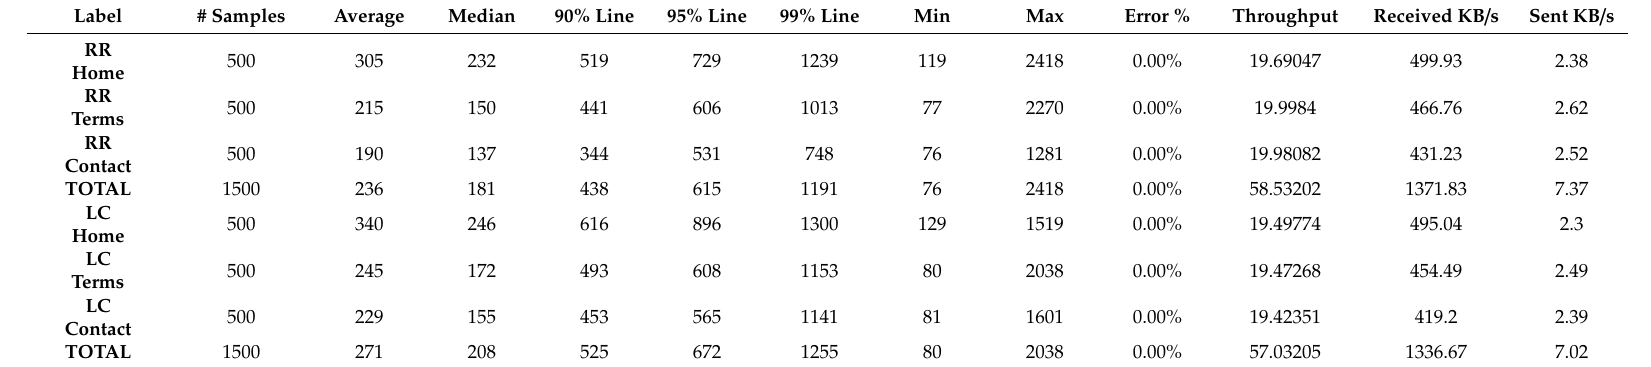
Table 4. Statistics table of the RR algorithm and LC algorithm for the first load test.